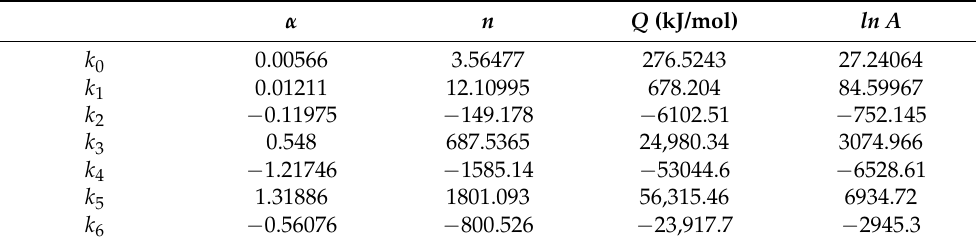
Table 2. Polynomial fit coefficients of α , n, Q , and ln A for the Ti − 65541 alloy of the α + β phase.